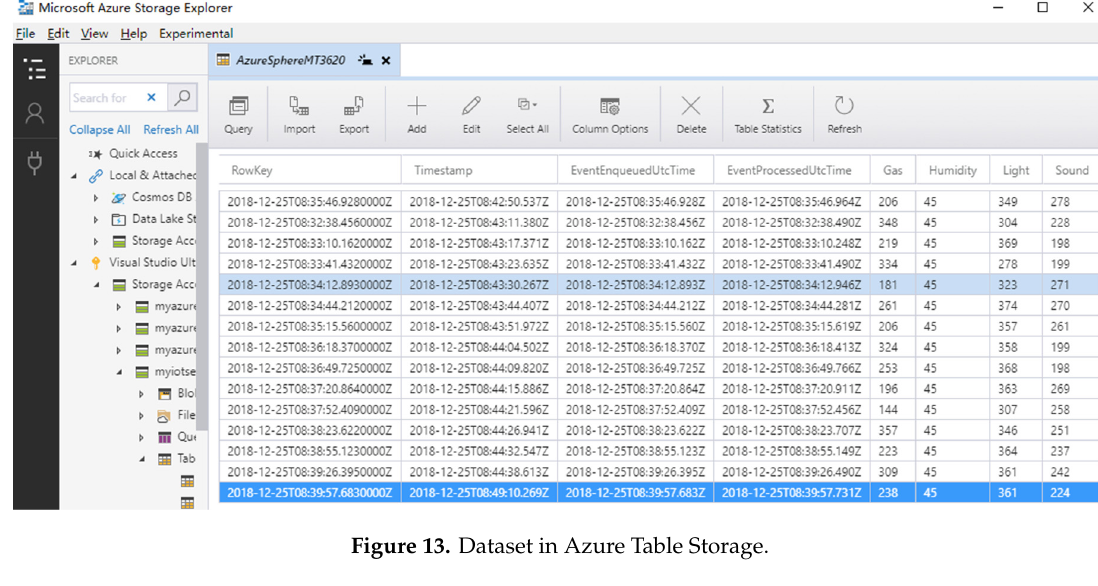
Figure 13. Dataset in Azure Table Storage.